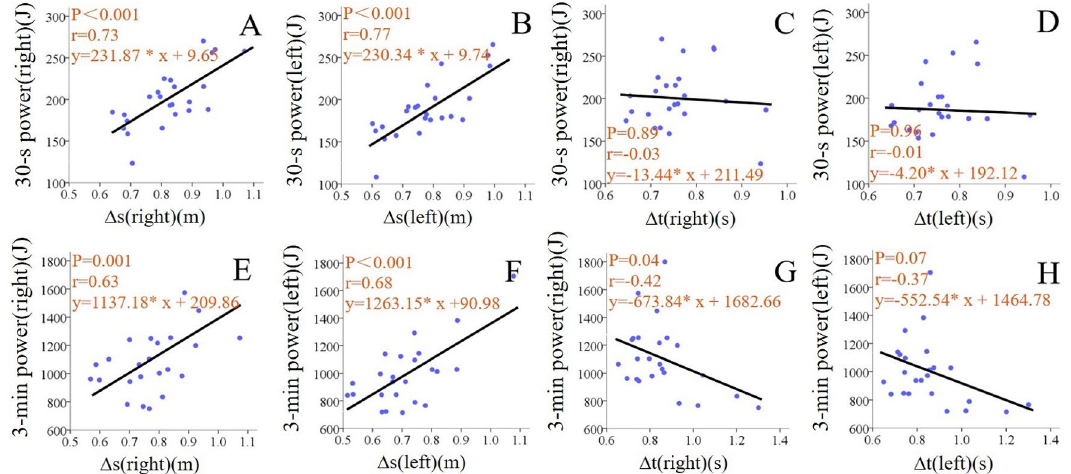
Figure 1. Correlations between ∆s, ∆t, and output power. Data from the left hand and right hand are calculated separately. (A,B) The relation between ∆s and 30-s output power. (C,D) The relation between ∆t and 30-s output power. (E,F) The relation between ∆s and 3-min output power. (G,H) The relation between ∆t and 3-min output